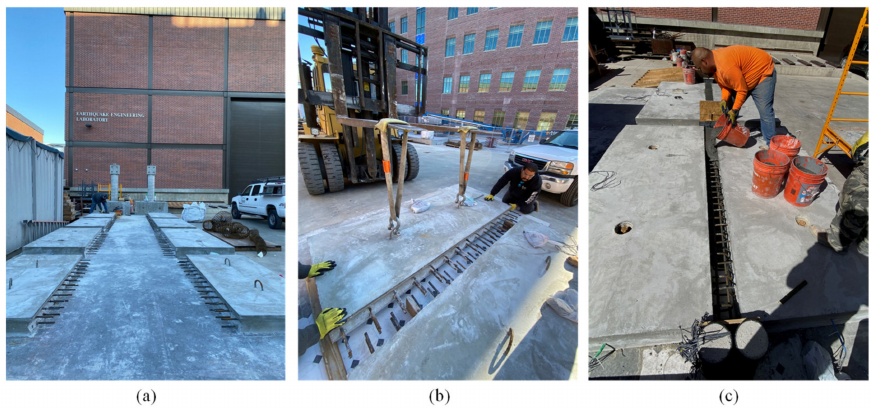
Figure 6. Construction of the test specimens ( a ) fabrication of the deck panels; ( b ) alignment of the deck panels; ( c ) pouring the NP-UHPC inside the field